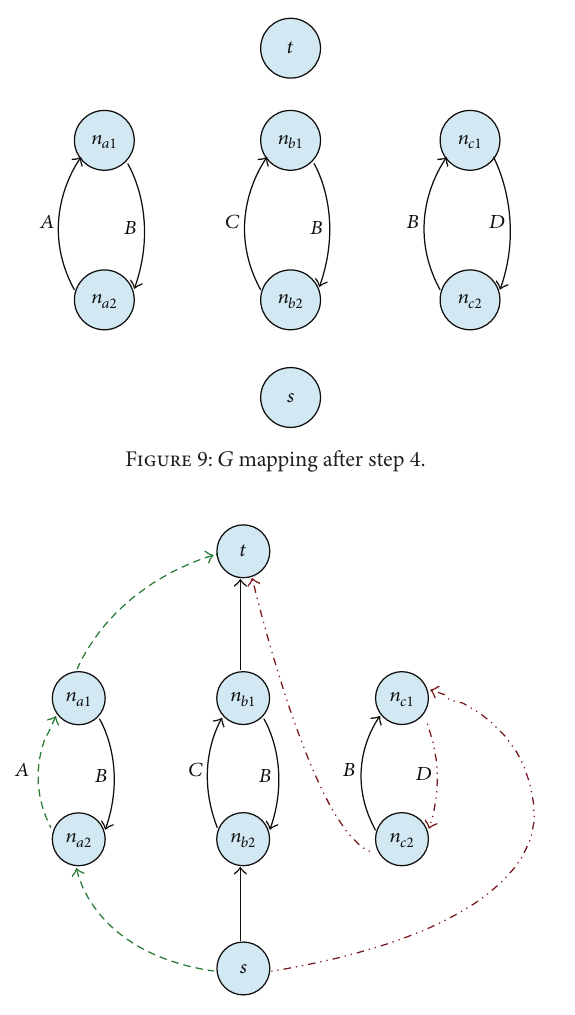
Figure 10: 𝐴 , 𝐶 , and 𝐷 paths belonging to the maximum indepen- dent set. These paths do not have any conflicting edges.